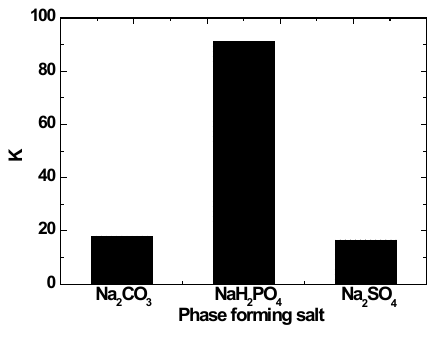
Figure 5. Effect of salt species on partition coefficient of ASPM. Figure 4. Effect of the amount of NaH